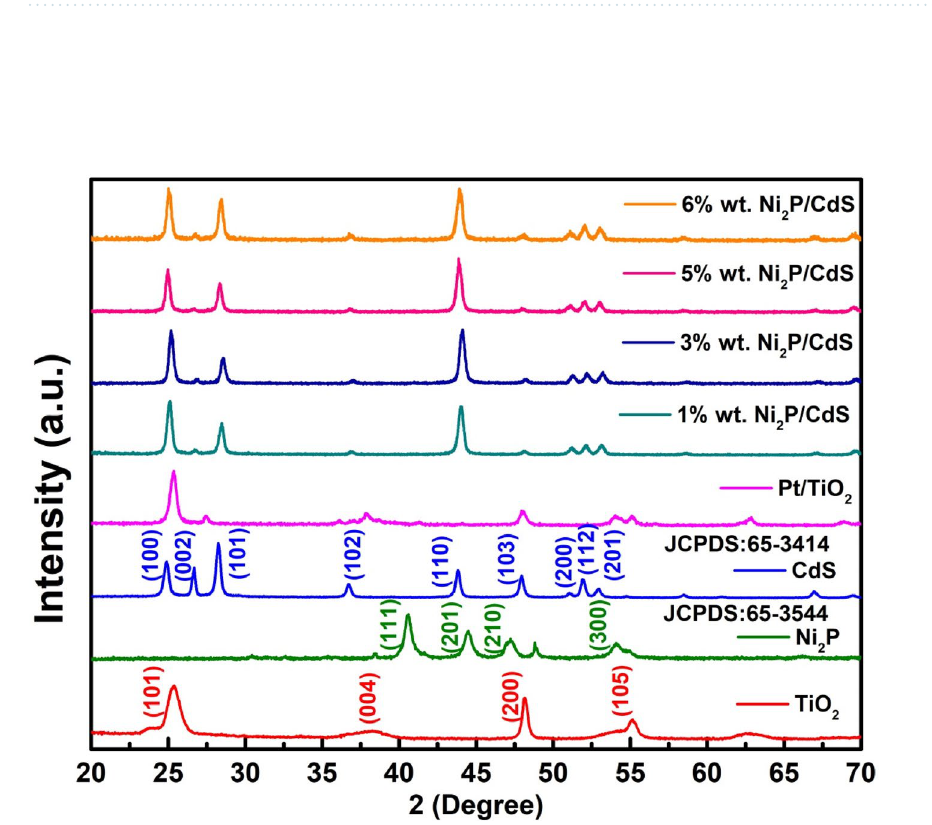
Figure 1. ( A ) XRD patterns of TiO 2 , Ni 2 P, CdS, Pt/TiO 2 CdS, 1 wt% Ni 2 P/CdS, 3 wt% Ni 2 P/CdS, 5 wt% Ni 2 P/ CdS and 6 wt%